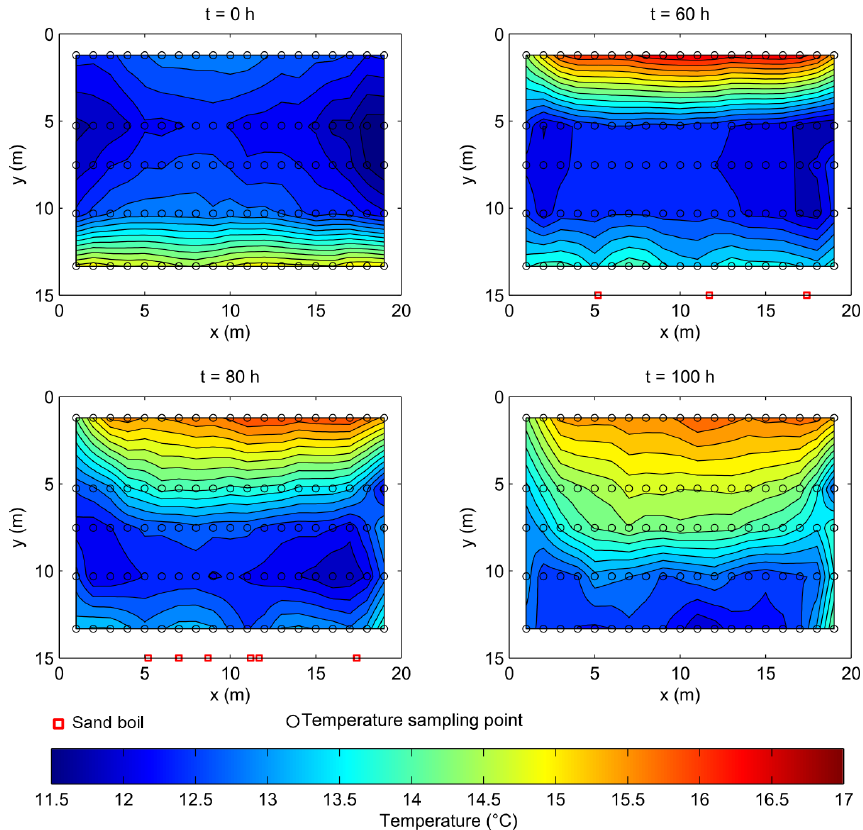
Figure 8. Temperature at the bottom of the dike at 0, 60, 80 and 100h from the beginning of the test (red squares indicate the position of sand boils and black circles the location of temperature sampling